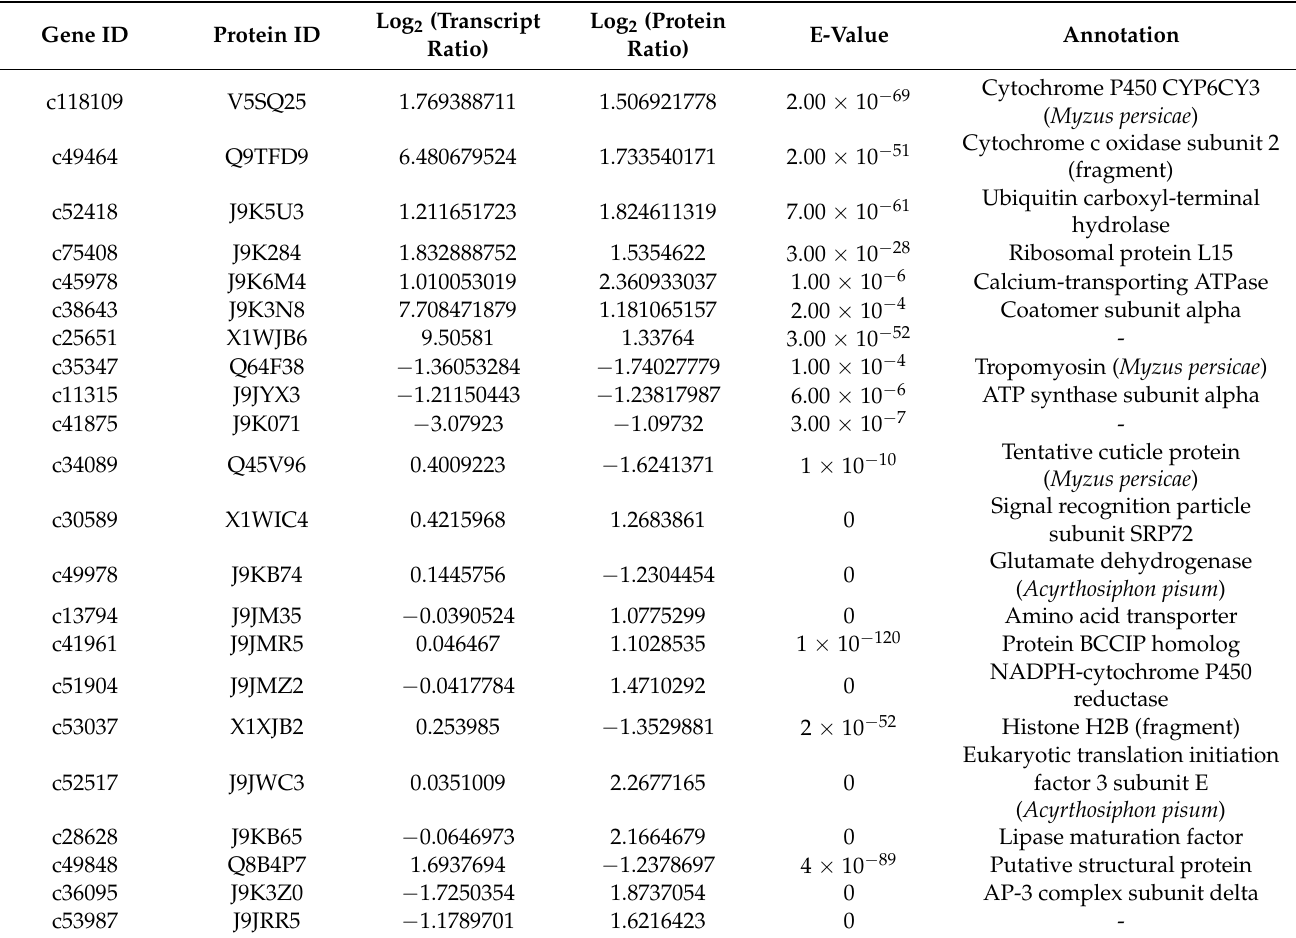
Table 5. Correlation between mRNA expression and the corresponding protein levels for 22 DEGs in CMV-infected adult M. persicae